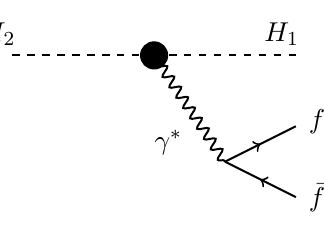
Figure 2 . Radiative decay of the heavy neutral particle H 2 ! H 1 (cid:13) (cid:3) ! H 1 f (cid:22) f . process H ! H f (cid:22) f , presented in (cid:12)gure 5. Here, the f (cid:22) f pair is produced through 2 1